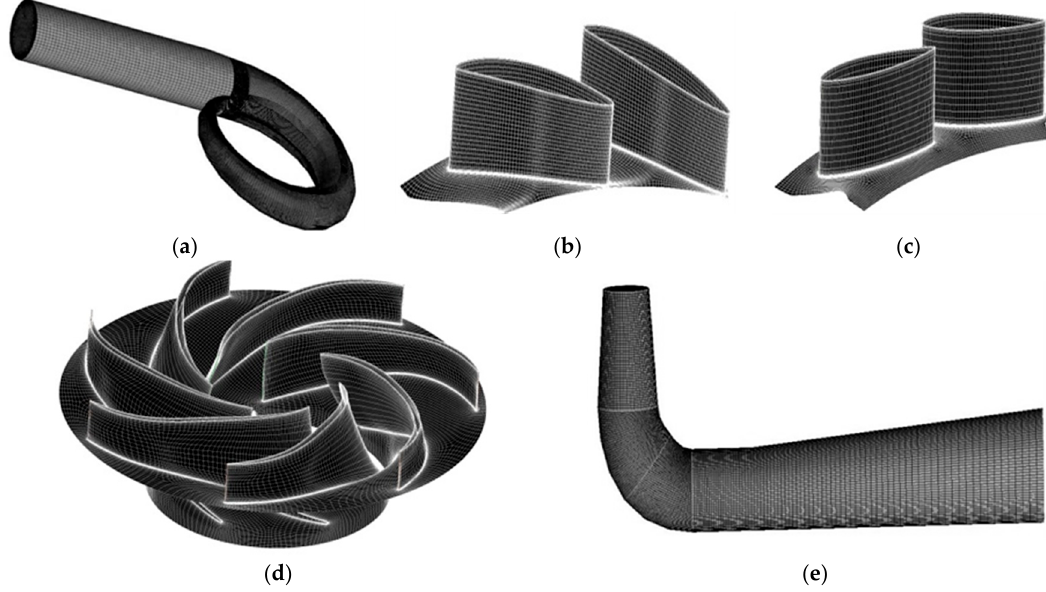
Figure 4. Boundary mesh for the full flow passage. ( a ) Spiral casing; ( b ) stay vanes; ( c ) guide vanes; ( d ) runner; and ( e ) draft tube.